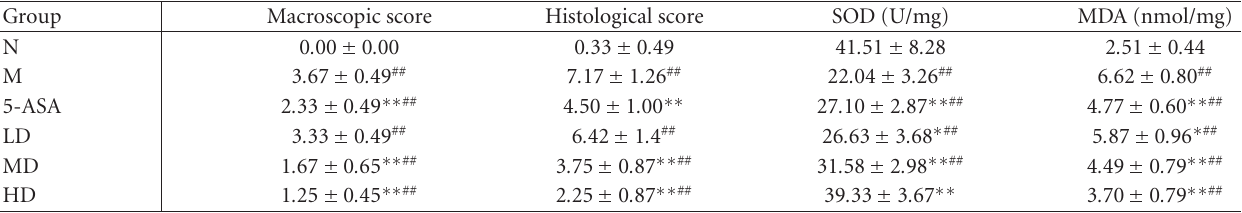
Table 1: E ff ects of EGB on the macroscopic and histological damage scores and the levels of SOD and MDA of colon tissues in rats. The SD ( n = 12). results were expressed as means (cid:0)